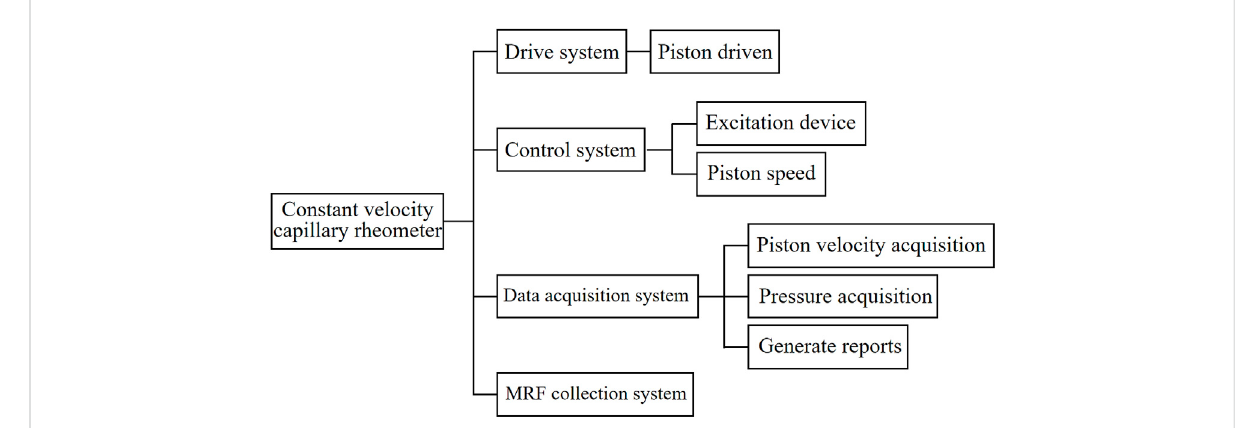
FIGURE 3 Principle structure block diagram of lab-made speed-controlled capillary